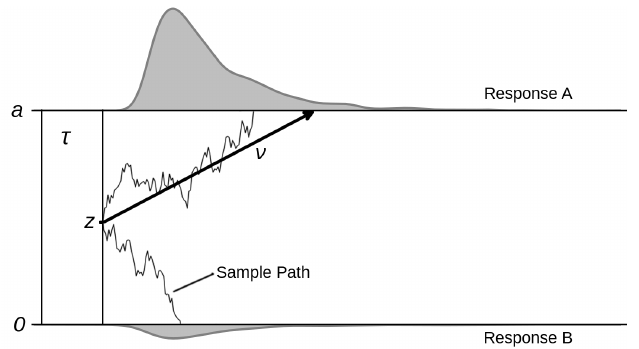
Figure 1. The diffusion model. The accumulation process starts at starting point z , moves with average slope ν and terminates when one of the two thresholds (0 or a ) has been reached. τ denotes the time taken for non-decisional processes, e.g., encoding and motoric response. On the top and the bottom of the figure, the two response time distributions are